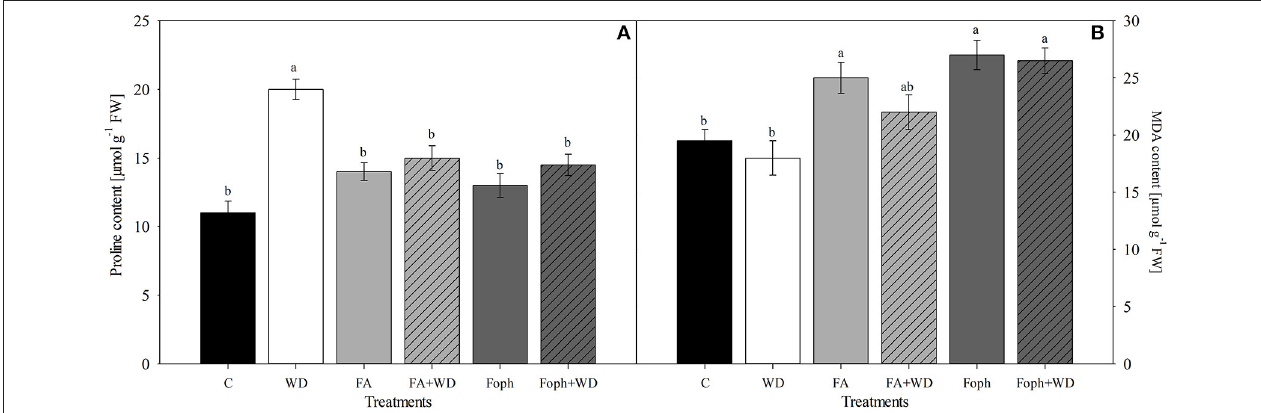
FIGURE 6 | Effect of water deficit (WD), exposure to fusaric acid (FA) and F. oxysporum f. sp. physali (Foph) inoculation and combination of WD and FA and WD and Foph on proline and malondialdehyde contents in cape gooseberry plant ecotype Colombia under hydroponic system conditions at 12 DAT. (A) Proline and (B) malondialdehyde (MDA) contents. Chart bars represent the mean of four values ± standard error ( n = 3). Bars followed by different letters indicate statistically significant differences according to the Tukey test ( P ≤